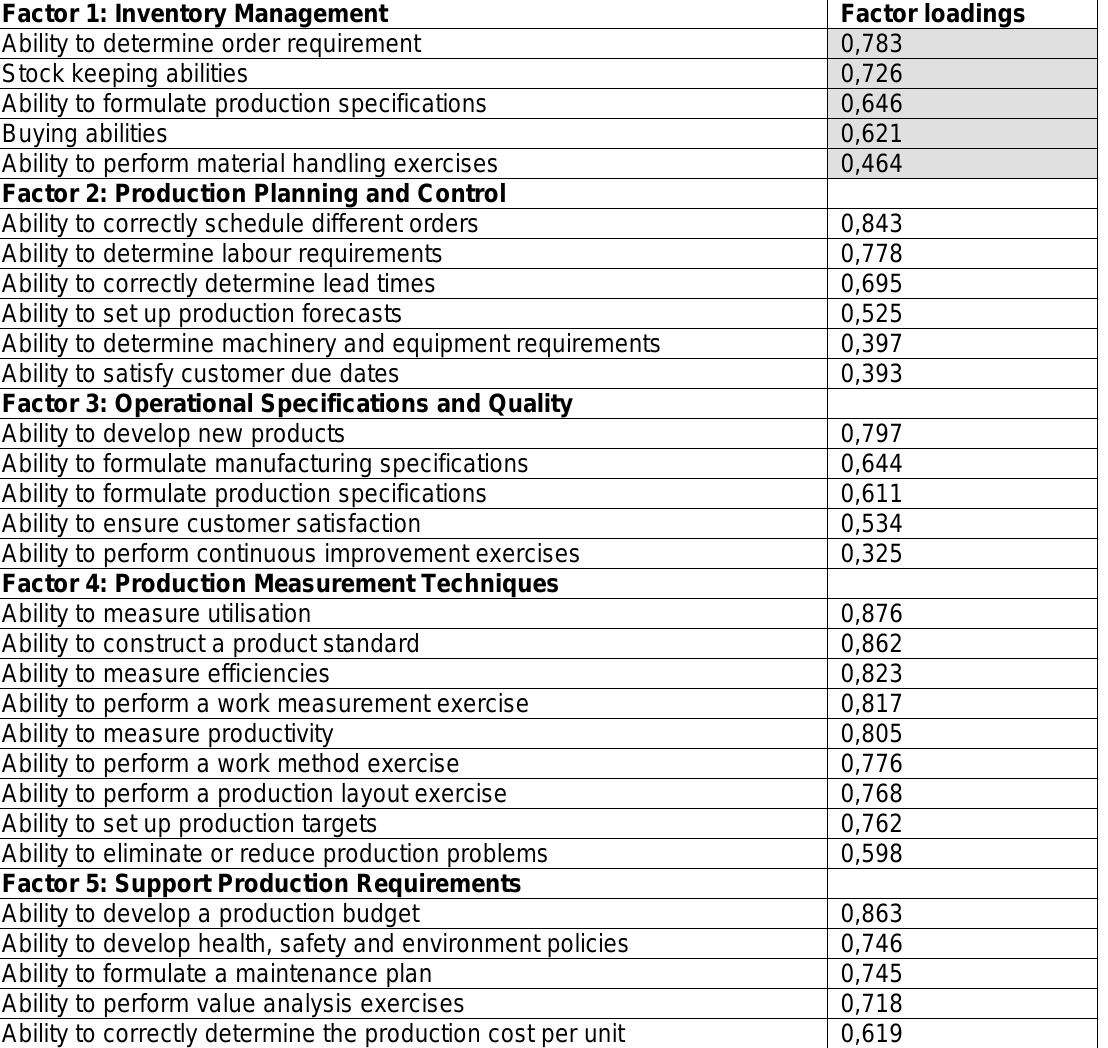
Table 3: Final sorted factor structure for operations skills Factor 1: Inventory Management